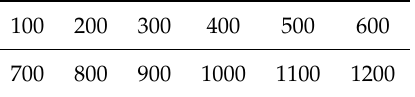
Table 2. KVAr ratings of the CBs units.